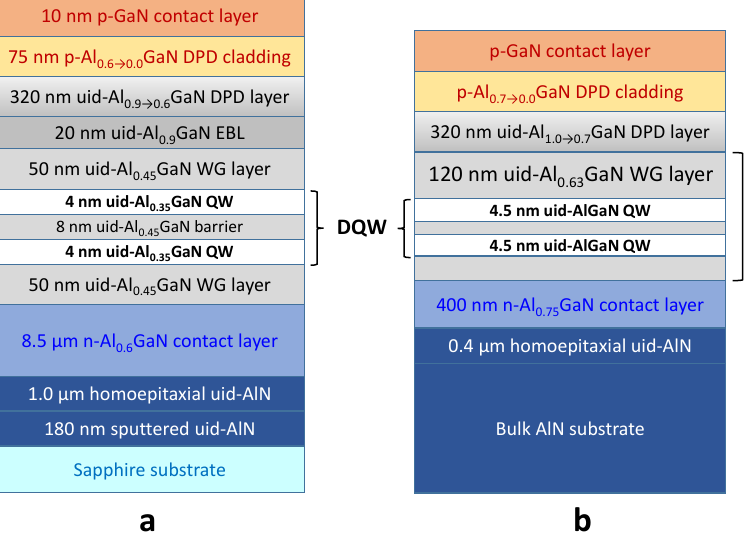
Figure 6. Schematic illustrations of typical structures of UVC LDs grown on a sapphire [24] ( a ) or a bulk AlN [25,26] ( b ) substrate. Unintentionally-doped epitaxial layers are marked by the acronym ‘uid’.